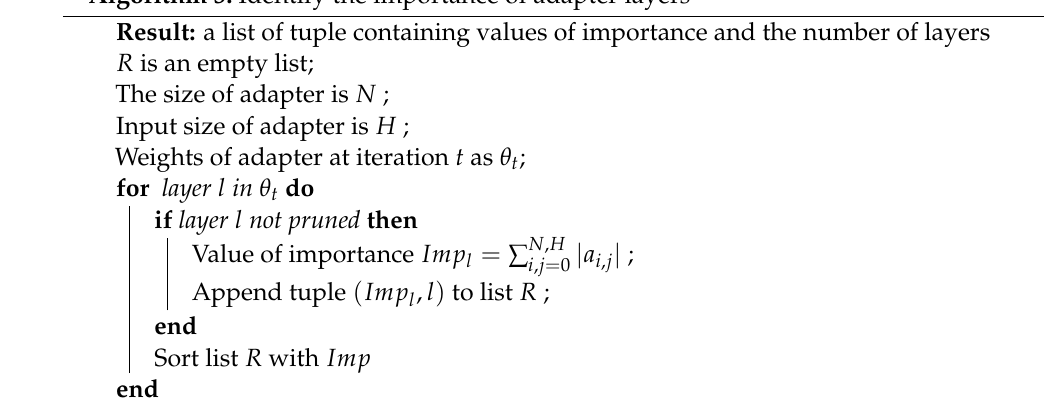
Algorithm 3: Identify the importance of adapter